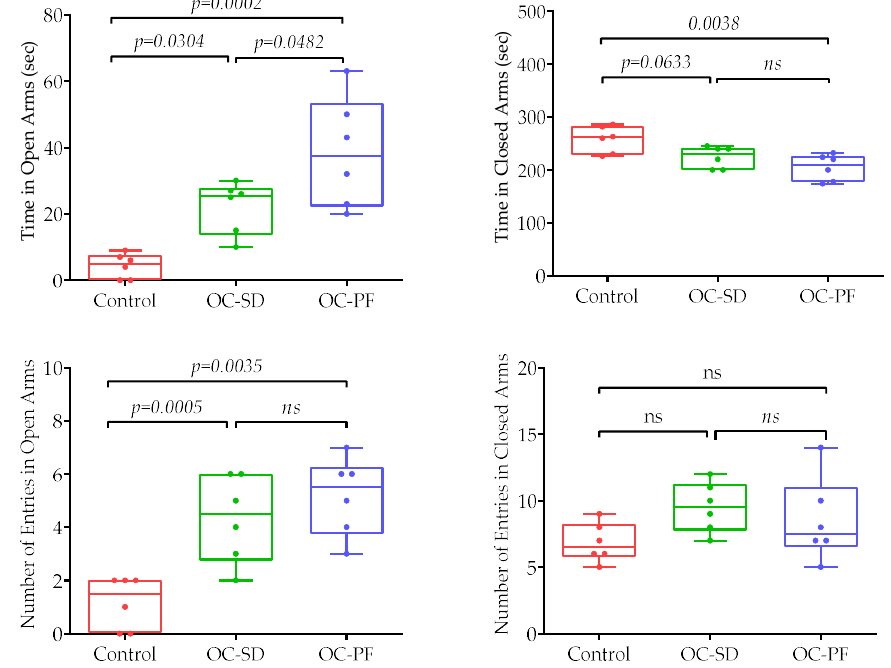
Figure 3. The effects of OC-PF and OC-SD treatments in 5xFAD mice using the elevated plus maze test. ( A ) Mice time in open arm (F (2, 15) = 14.99, p < 0.05). ( B ) The number of tested mice entries in open arms F (2, 15) = 13.82, p < 0.05). ( C ) The time taken by tested mice in closed arm (F (2, 15) = 7.80, ns and p < 0.05). ( D ) The number of tested mice entries in closed arm F (2, 15) = 2.099, ns.